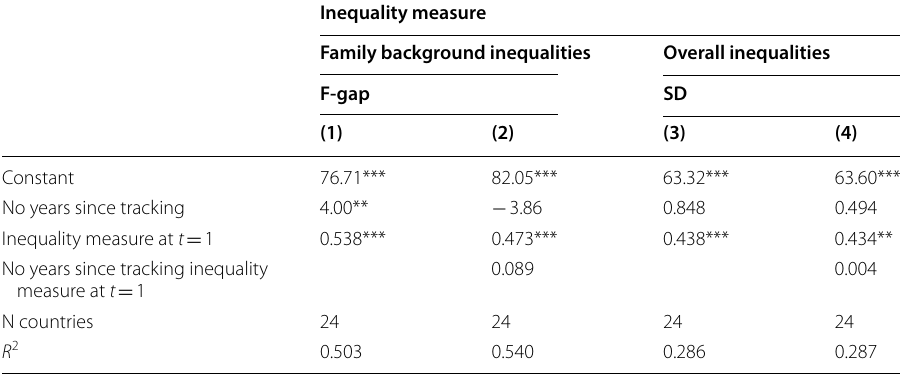
No years since tracking is defined as (15 age of tracking) if tracking occurs up to age 15, is equal to − after age 15 (not yet occurred). Under the heading SD we report results relative to the effects of tracking on the country standard deviation Under the heading F‑gap we report results relative to the effects of tracking on the difference between tertiary educated parents with the largest number of books and no tertiary educated parents with the lowest number of books: c 1 c 2 ] c 1 , where c 1 and c 2 are the coefficients of the family background variables: ln(books) and F‑gap [ln(500) ln(5) = × + − × tertiary education Columns (1) and (3) refer to the model with no interaction; columns (2) and (4) to models with interaction between the tracking indicator and inequality at